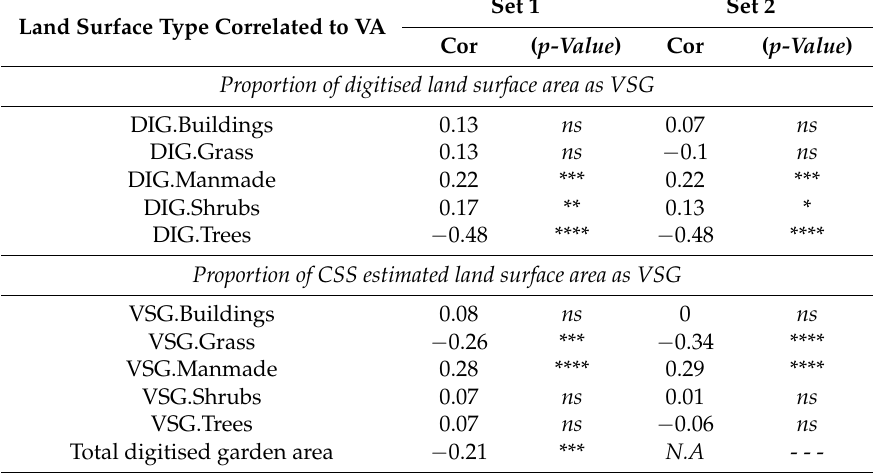
Table 5. Association between VA and land surface types estimated from digitisation and CSS